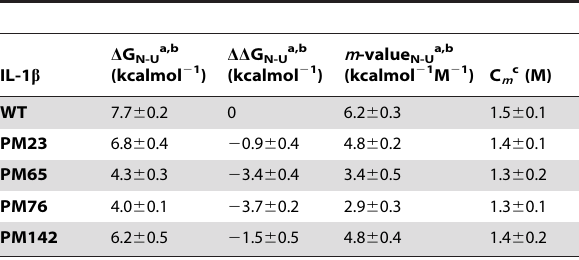
Table 1. Thermodynamic Parameters for WT IL-1 b and All Permutant Variants.